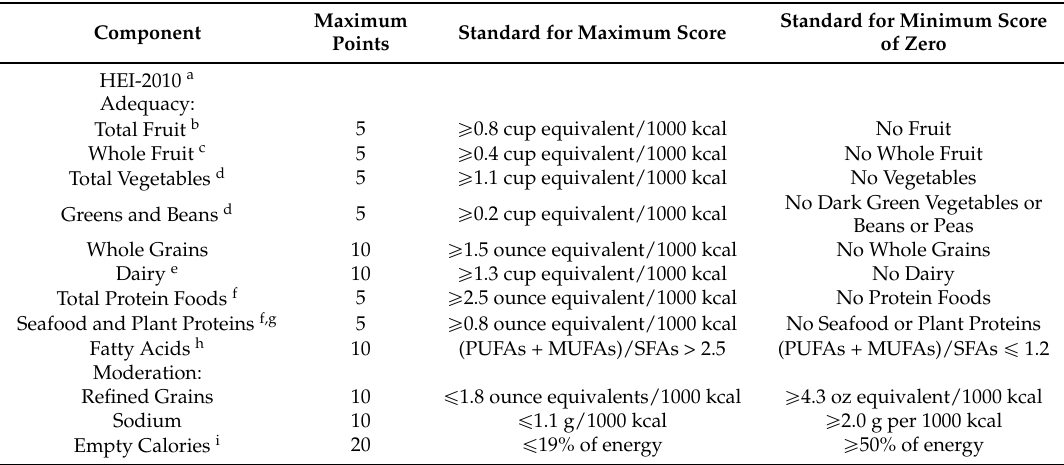
Table 1. The Healthy Eating Index (HEI)-2010 components and